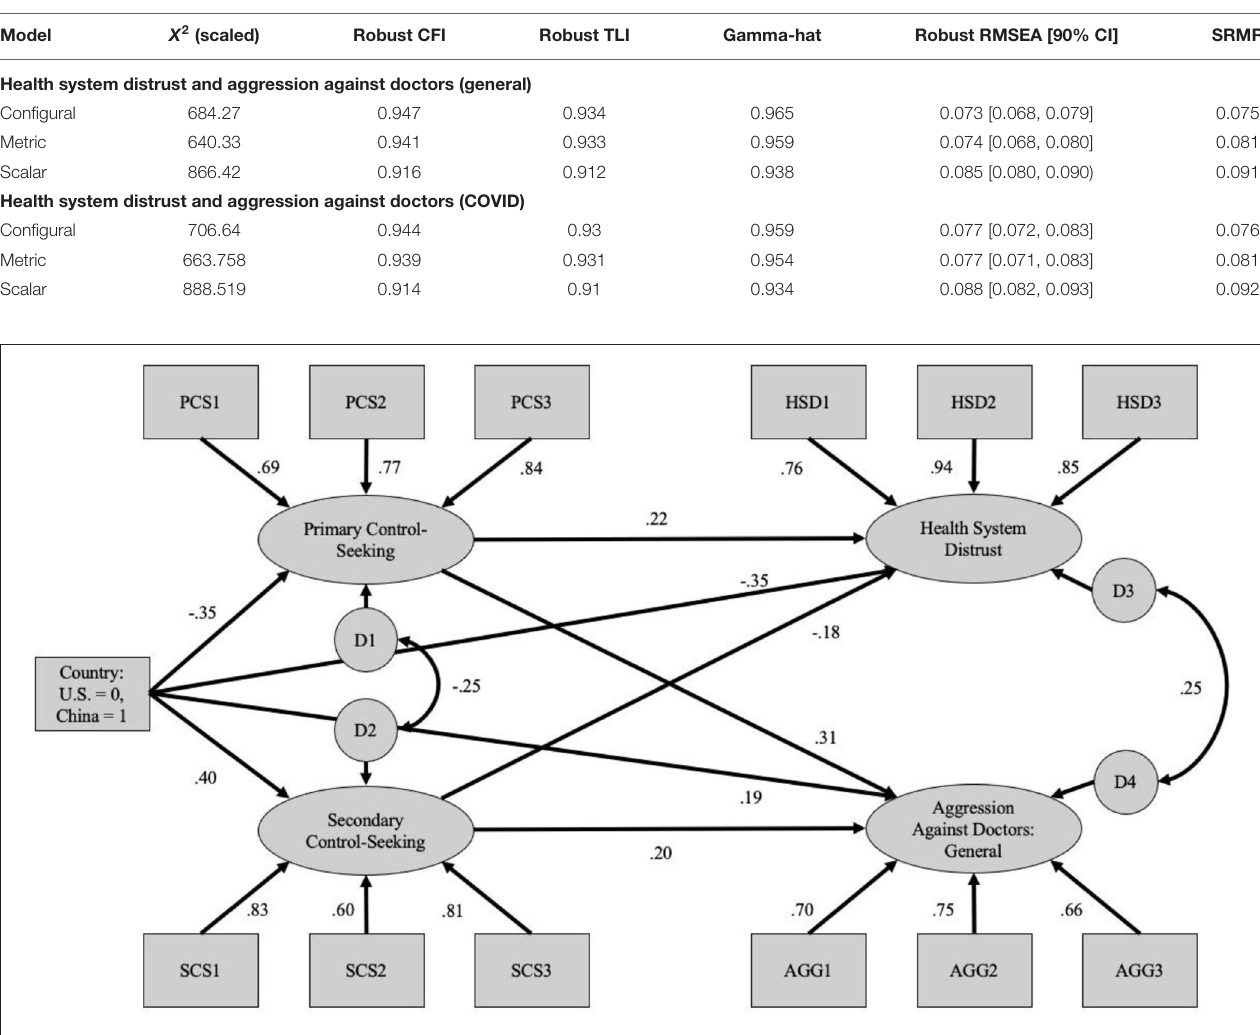
TABLE 4 | Fit statistics for invariance models (Study 2).